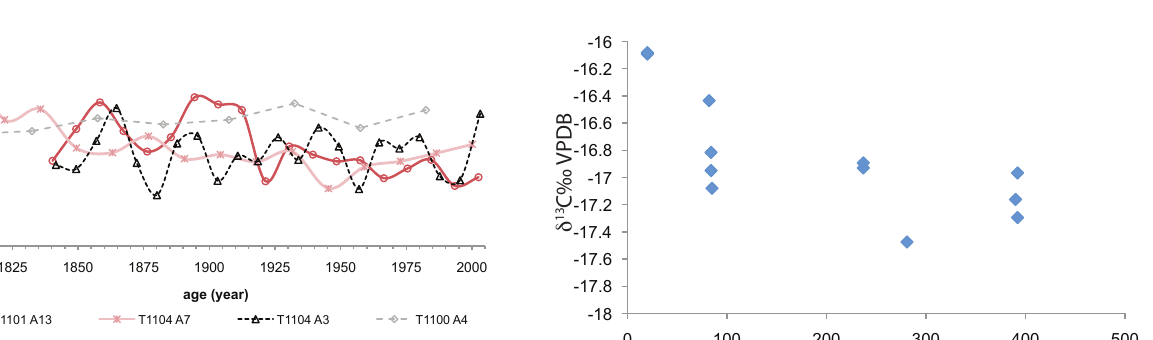
Figure 6. Centennial-length δ 15 N records from four corals: T1101 A13 (hollow circles, solid line), T1104 A7 (*), T1104 A3 (hollow triangles), and T1100 A4 (hollow circles, dashed line). Age models based upon calculated extension rates in Table 3, and assume a con- stant extension rate throughout the sampling of the coral. Records show overall stability in δ 15 N over time.